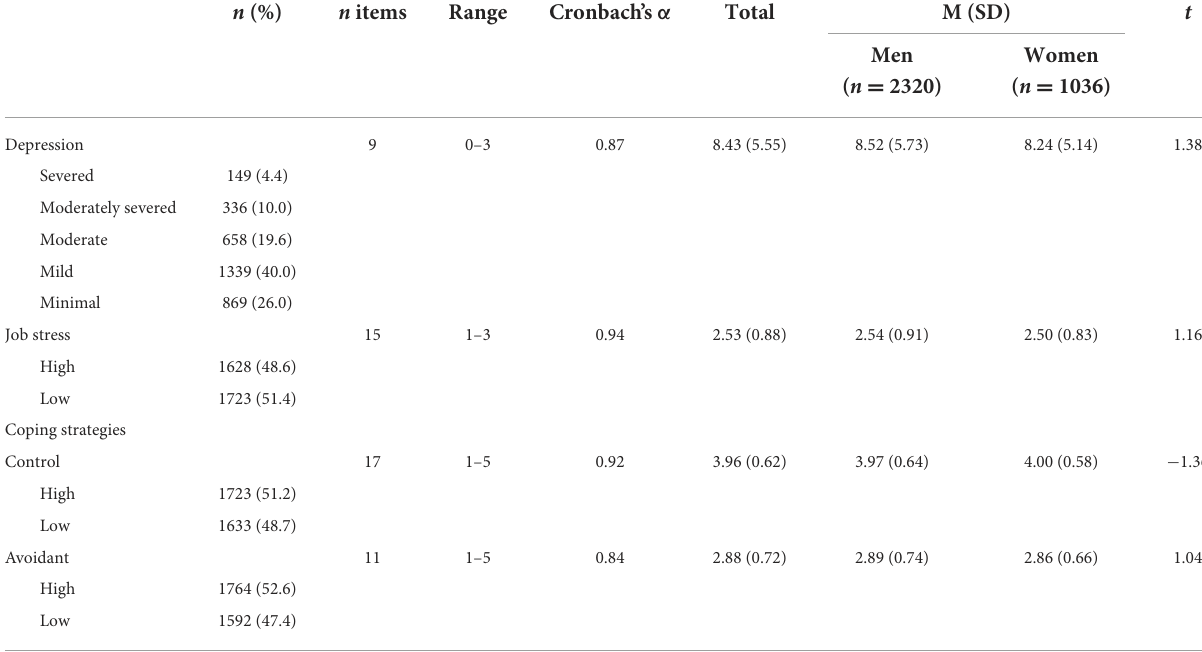
TABLE 1 Psychometric properties of the questionnaires for depression, job stress, control coping and avoidant coping ( n = 3356). n (%) n items